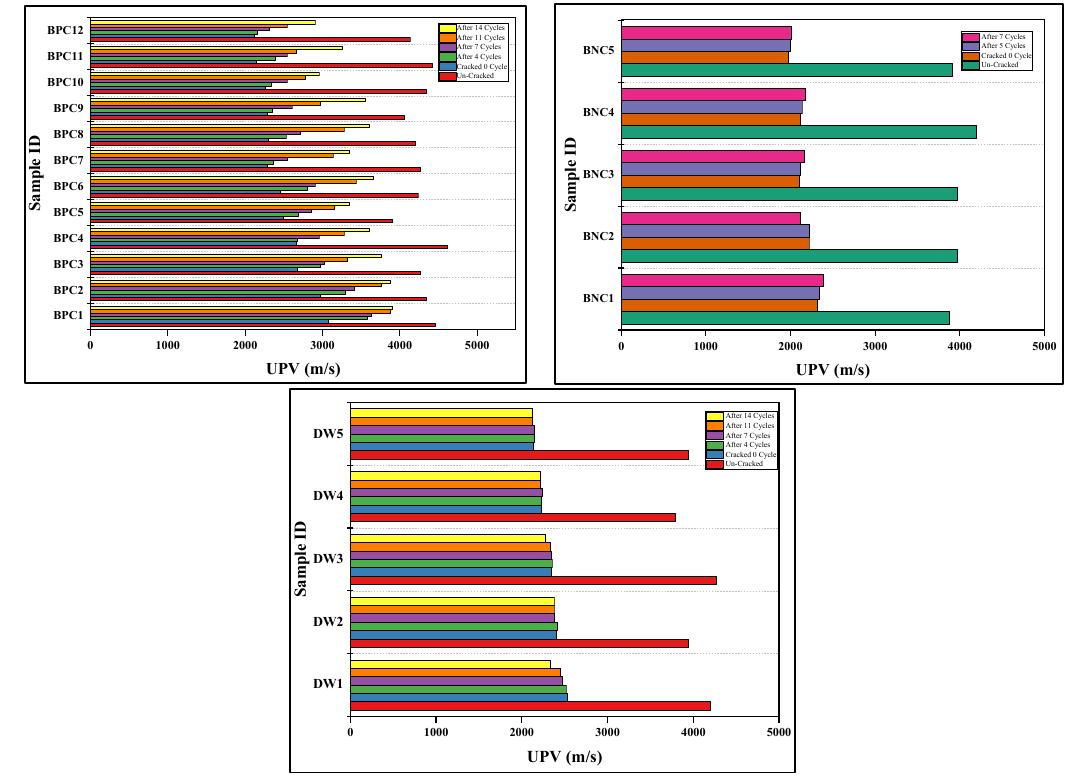
Figure 13. Relative change in ultra ‐ sonic values after different repair treatments. Changes in ultra ‐ sonic value for samples treated with biodeposition without Ca ‐ source repair are displayed in Figure 13. Before treatment, the ultra ‐ sonic values of the sample with said repair ranged from 3907 to 4198 m/s, indicating a reduction of nearly 50–55% compared to the control sample (Supplementary Materials S5). After the treat ‐ ment, the obtained ultra ‐ sonic values ranged from 2000 to 2300 m/s, indicating that the recovered ultra ‐ sonic value was only 50–60% of the control sample. The mortar’s overall quality did not improve as much as it did with previous biodeposition treatments. Pri ‐ marily this is because of the absence of a Ca ‐ based food source, resulting in less calcifica ‐ tion and crack closure. Similarly, the ultra ‐ sonic measurement for distilled water ‐ treated samples is shown in Figure 13. The recovered ultra ‐ sonic value was only 52–55% of the control sample, which is relatively low because this treatment mostly involved autogenic healing (Supplementary Materials S5).